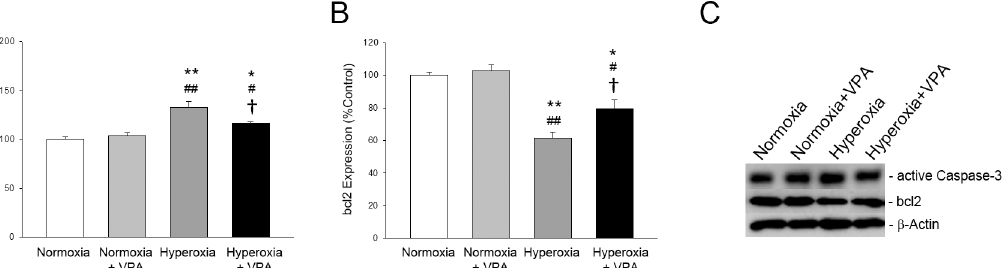
Fig 5. Bar graphs depicting active Caspase-3 (A) and bcl2 (B) expressions in lung tissues of rat pups. Panel C depicts representative bands for each protein, including β -Actin, the protein which was used as a loading control for western blotting. * p < 0.05 and ** p < 0.001 compared to Normoxia group; #p < 0.05 and ##p < 0.001 compared to Normoxia+VPA group; and † p < 0.05 compared to Hyperoxia group using One-Way ANOVA followed by post-hoc Tukey